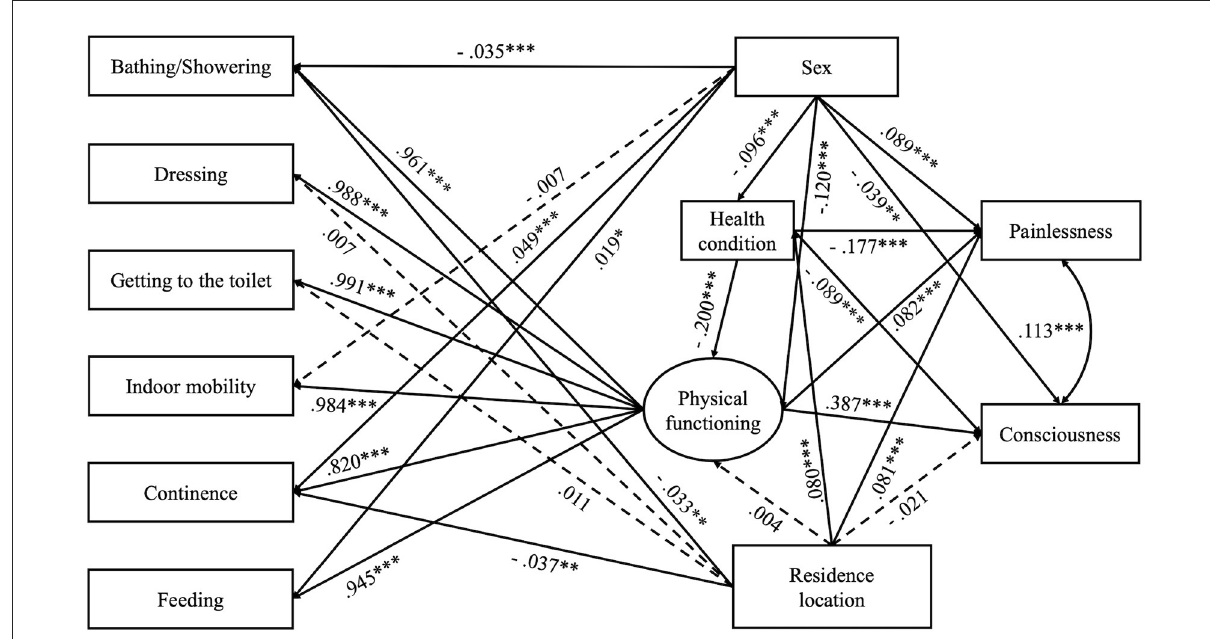
FIGURE2 SEM model of associations between life prior to death and quality of death based on gender and residence location. All slope coefficients presented are standardized estimates, * p < 0.05, ** p < 0.01, *** p < 0.001. χ 2 (df) = 293.502 (26), p < 0.001; CFI = 0.999; TLI = 0.999; RMSEA = 0.033, 90% CI: [0.029, 0.036]; SRMR =